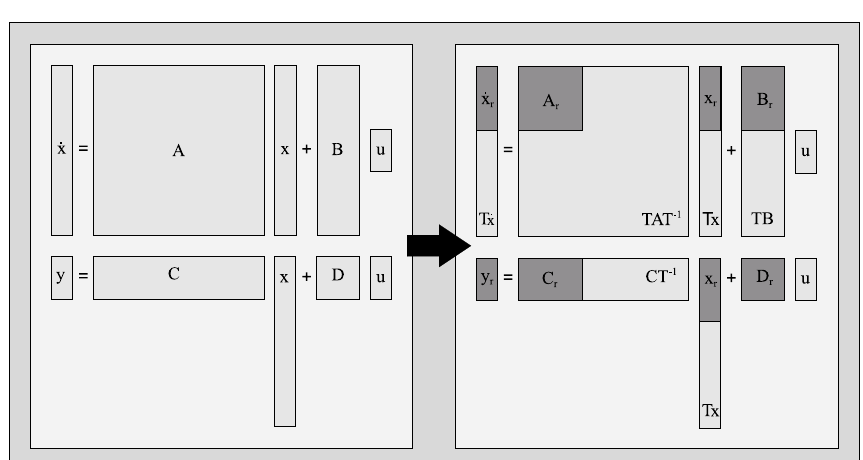
Figure 1: Order reduction by projection